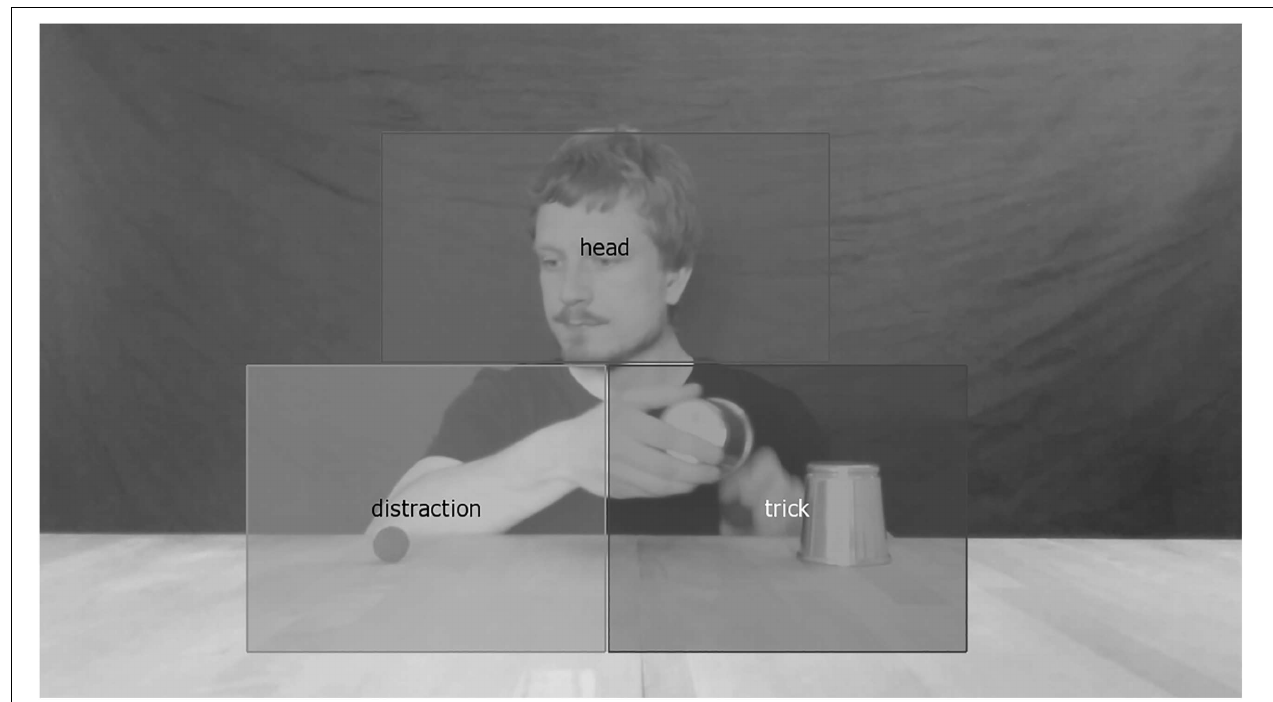
FIGURE 4 | Position and size of the three areas of interest (AOIs) relative to the performer, the cups, and the balls. The scene chosen shows the moment in which the green ball is being loaded (in the trick AOI), while the performer directs his gaze (in the head AOI) toward the red ball (in the distraction